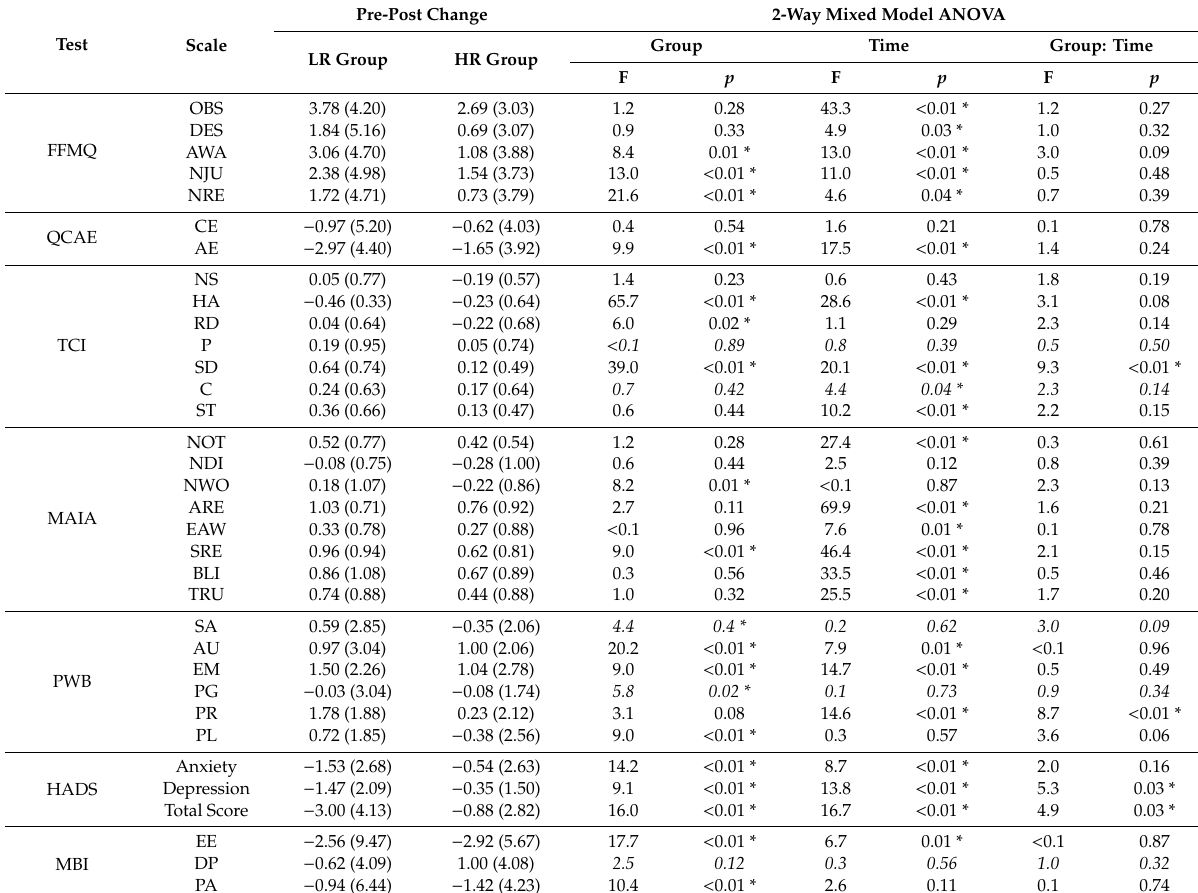
Table 3. Pre / post change in the scores (calculated as post score minus pre score; expressed in the table as average change and standard deviation) and results of the ANOVAs (detailed for the main e ff ect of Group, the main e ff ect of Time and the interaction e ff ect between Group and Time). For TCI, z-scores are used (obtained as in Table 2). Text in italics indicates that results were obtained using a robust version of ANOVA. Abbreviations are as in Table